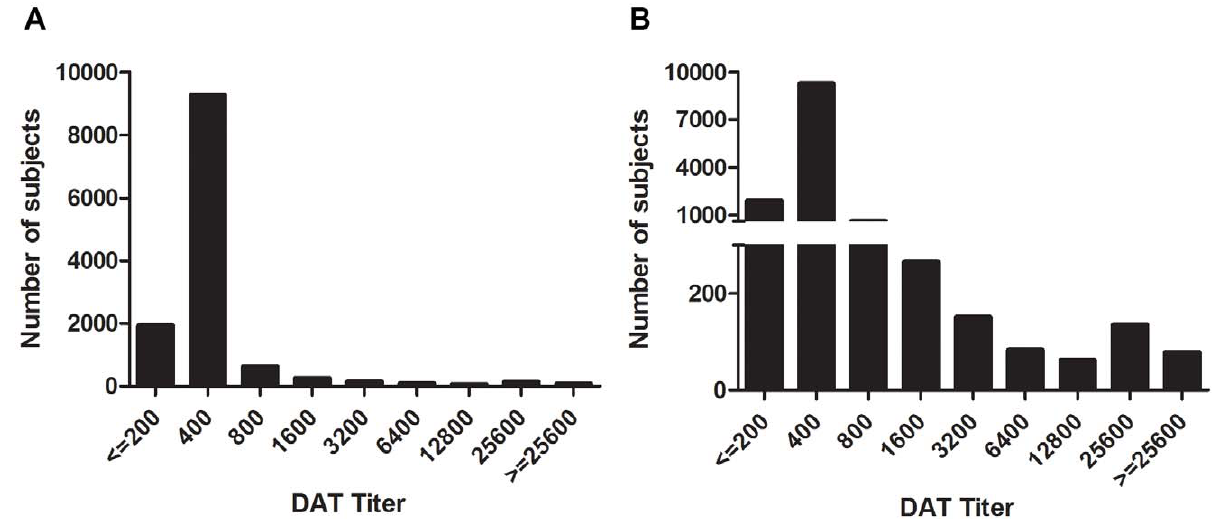
Figure 1. DAT titers at baseline. Serologic titers are graphed for the 12,634 subjects without prior or current VL, measured by the DAT test. Numbers of subjects with positive DAT tests at the indicated dilution are shown. The two graphs show the same data on different scales, so that both large and small titer peaks can be appreciated.